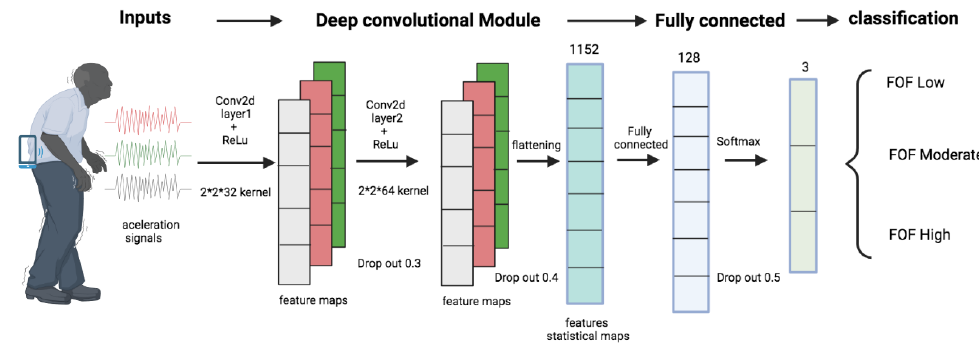
Figure 1. Diagram of the CNN model.